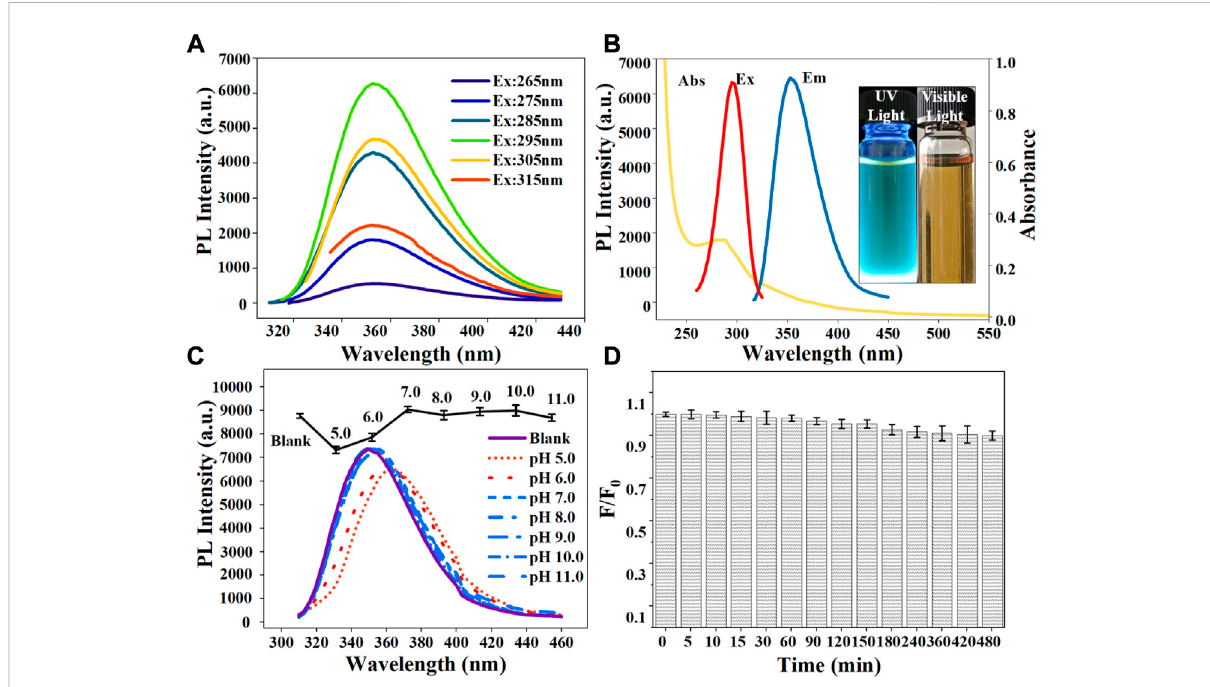
FIGURE 3 (A) Fluorescence emission spectra of N-CDs under different excitation wavelengths ranging from 265 to 315 nm; (B) UV – vis absorption, maximum fl uorescenceexcitation,andmaximumemissionspectraofN-CDs.Inset:photographsofN-CDssolutionunder365 nmUVlight(left)and visible light (right); (C) Effect of pH on the fl uorescence intensity of the N-CDs; (D) Effect of irradiation time with a 365 nm UV-lamp on the photostability of